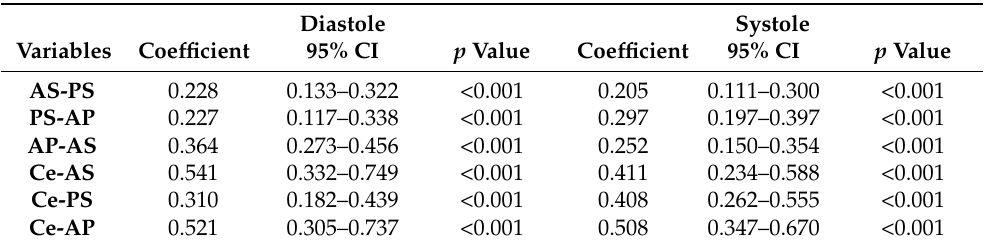
Table 4. Linear multiple regression analysis of novel CT variables associated with automated annulus area: estimated model coefficients and statistical significance of the independent